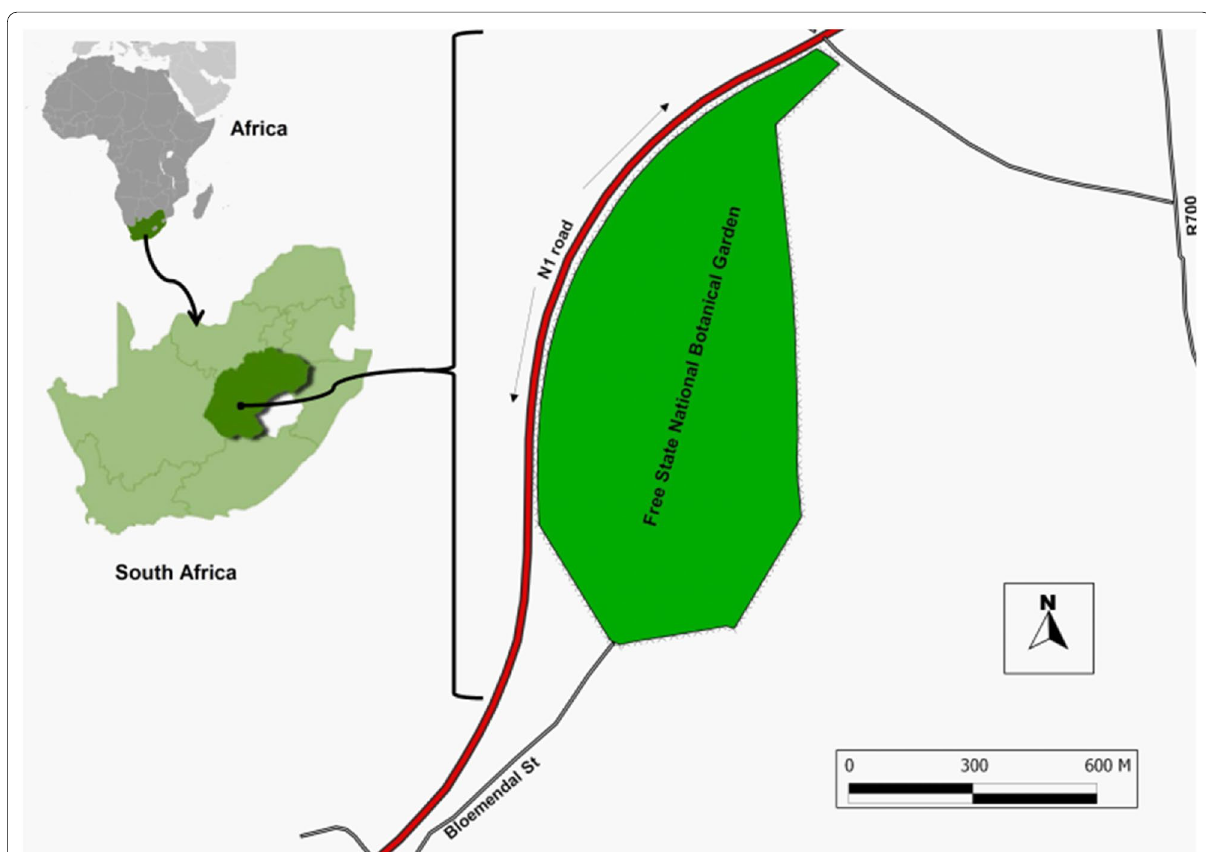
Fig. 1 Location of the study area: Free State National Botanical Garden, Bloemfontein in South Africa